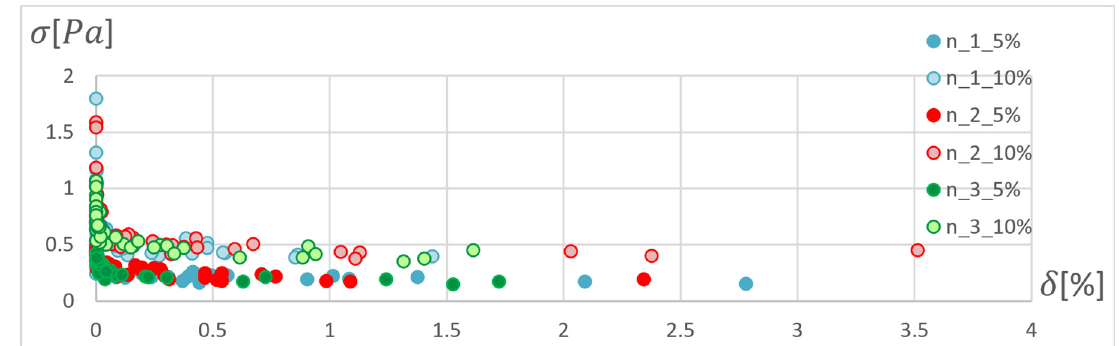
Figure 10. Pareto fronts for all networks trained using the GDM algorithm.